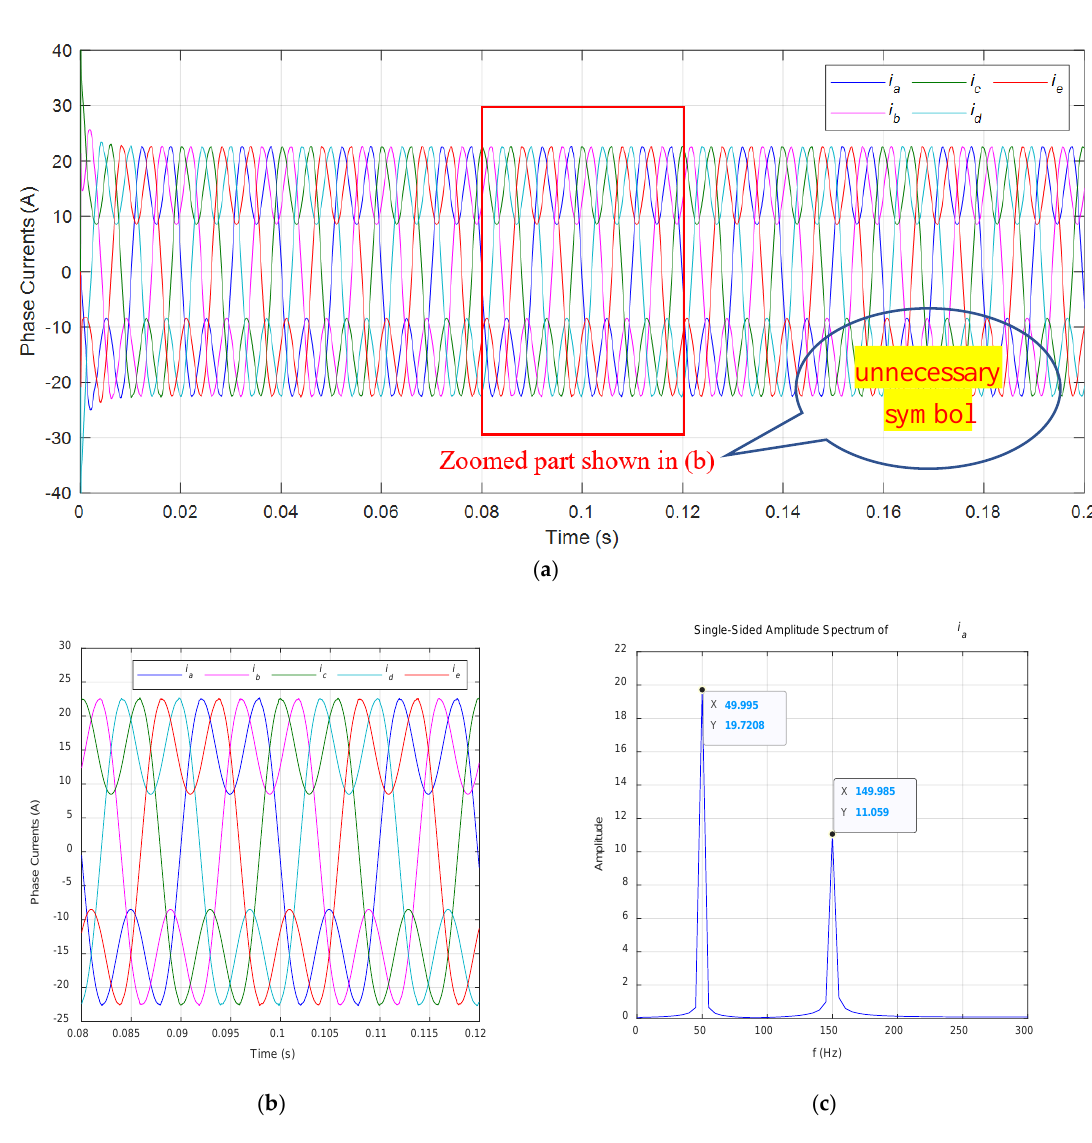
Figure 4. Terminal currents of the FP-PMSG with THWs without faults and Fast Fourier transformation of phase a current. ( a ) Terminal currents of the FP-PMSG with THWs in normal condition with v 0 = 3.6 m/s. ( b ) Zoomed terminal currents of FP-PMSG between 0.07 s and 0.12 s. ( c ) Fast Fourier transformation of the terminal current of phase a.